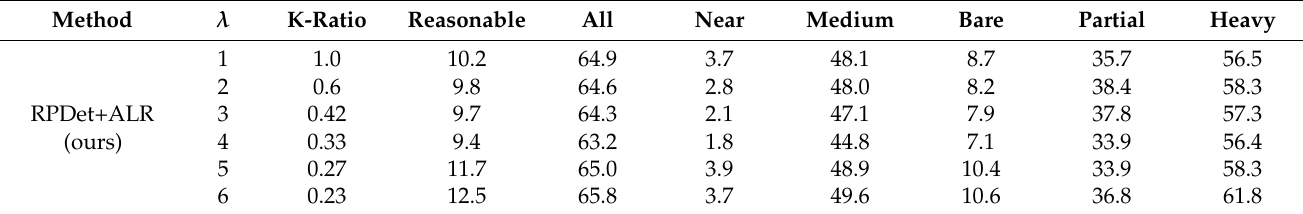
Table 3. Results of RPDet+ALR with varying λ on the Caltech-USA testing test (MR −2 /%). Method